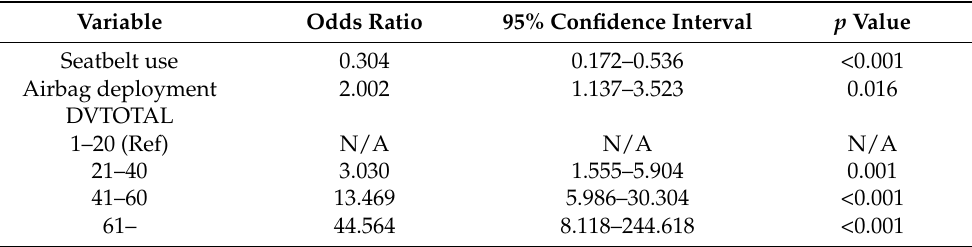
Table 2. Results of logistic regression analysis to predict moderate to severe injuries in preg- nant women.